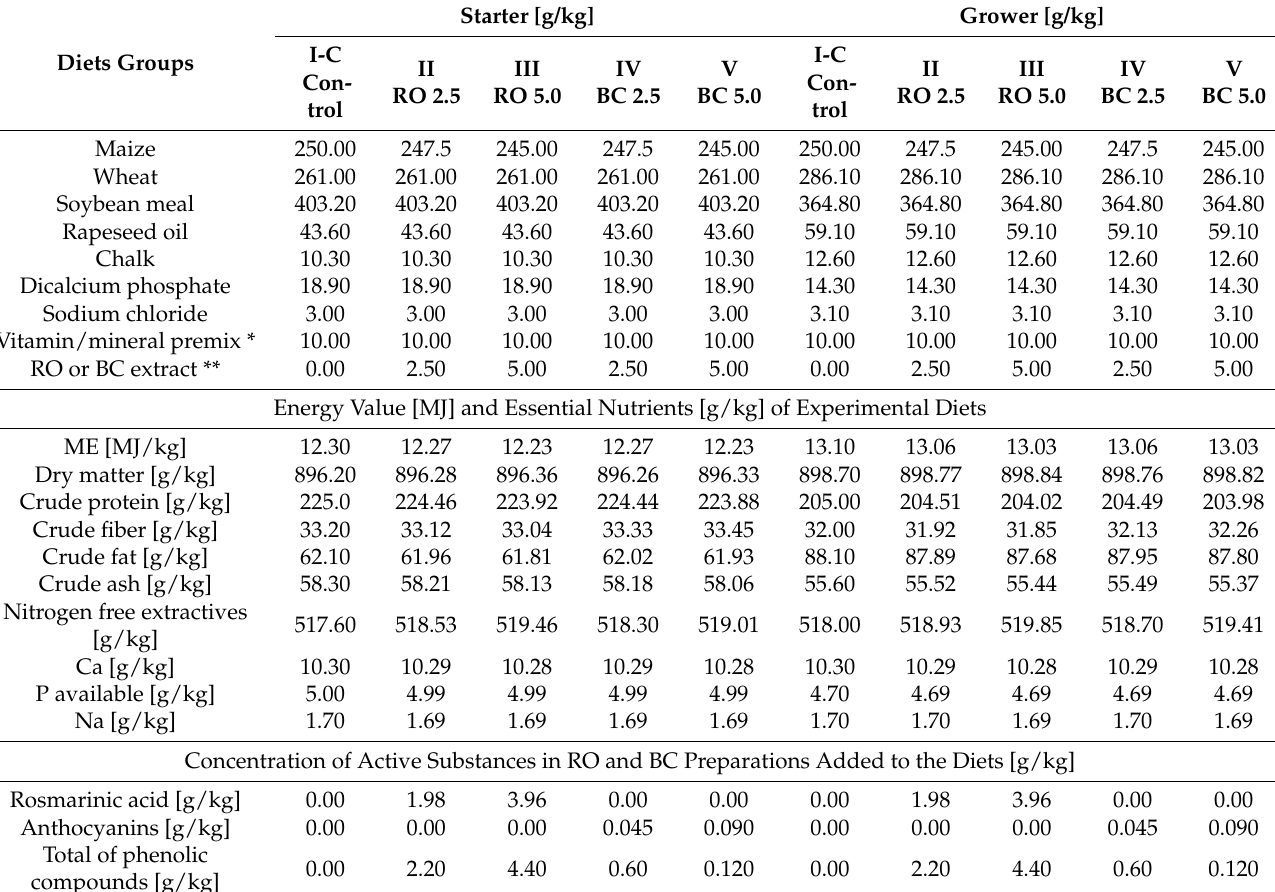
Table 1. Composition of the experimental starter and grower diets fed to